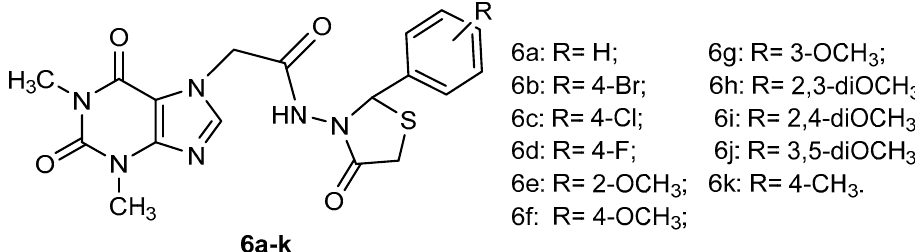
Figure 1. The structure of the xanthine derivatives with thiazolidine-4-one scaffold (XTDs: 6a-k).